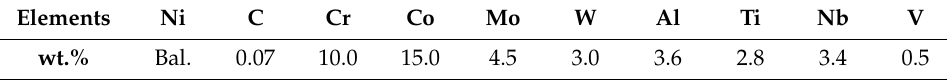
Table 1. Chemical composition of the GH4151 superalloy (major elements).